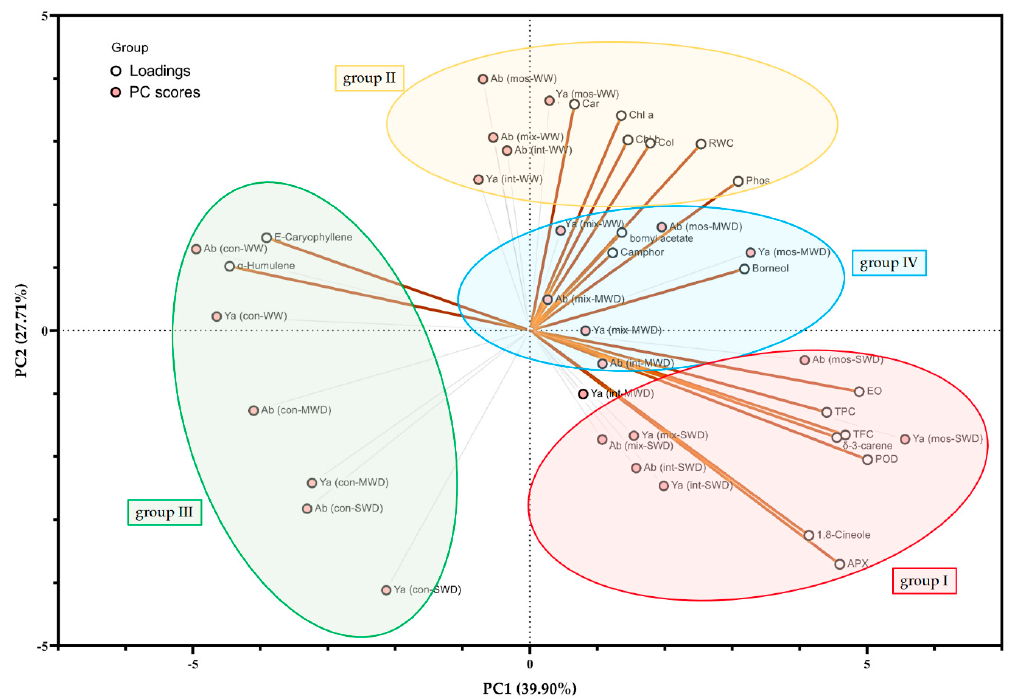
Figure 5. The principal component analysis (PCA biplot showing PC scores (mauve-filled circles) and loadings (white-filled circles) based on all biochemical parameters under different irrigation regimes followed by AMF inoculation in S. abrotanoides and S. yangii .